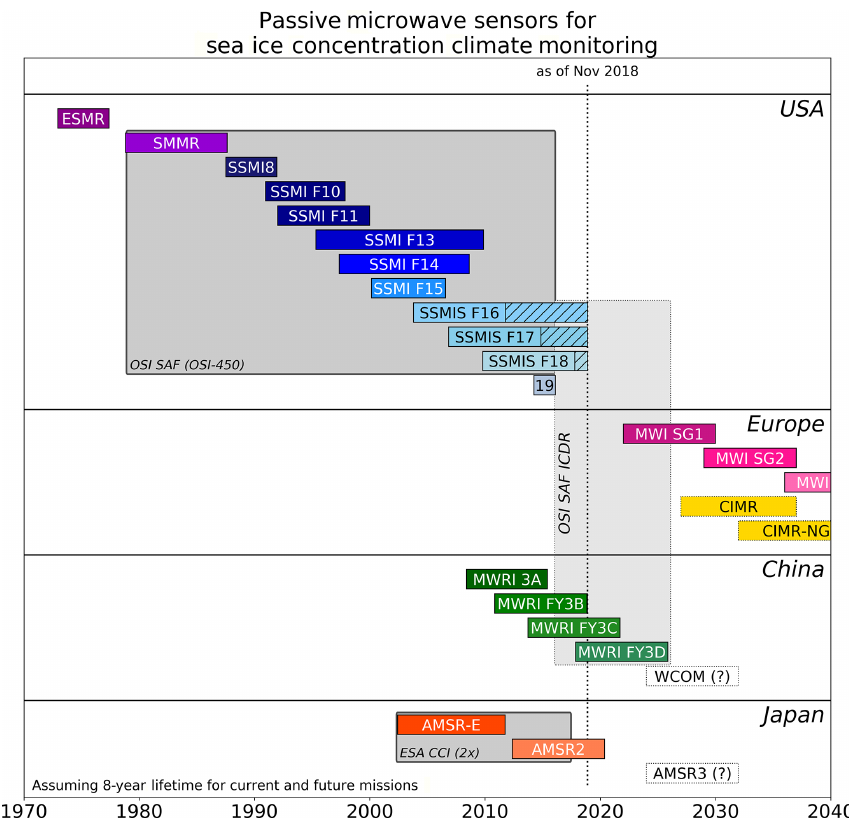
Figure 1. Time-coverage diagram for the new ESA CCI and EUMETSAT OSISAF SIC CDRs. The ESA CCI CDR is based on medium- resolution AMSR-E and AMSR2 sensors, while the EUMETSAT OSISAF CDR uses the coarse-resolution SMMR, SSM/I, and SSMIS instruments. Other current and future passive microwave instruments, as well as the OSI SAF ICDRs, are discussed in our Outlook, Sect.